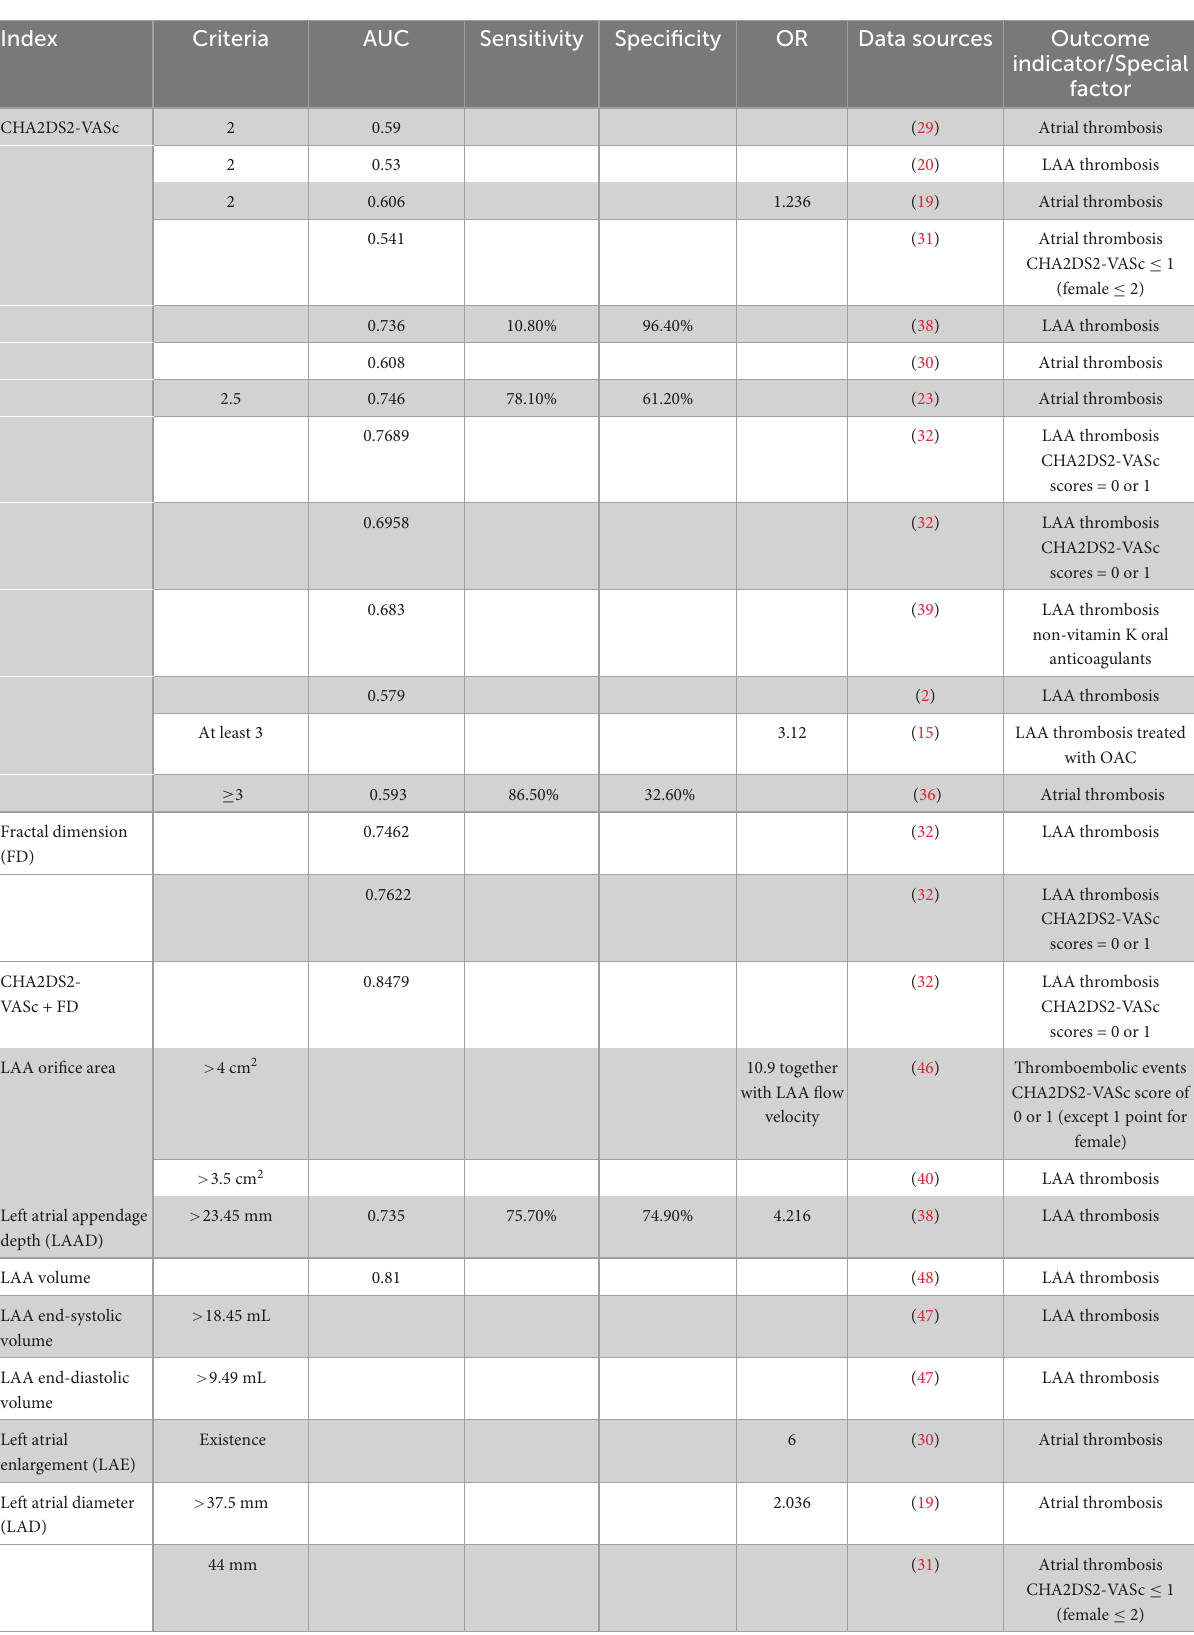
TABLE 1 Data and resources of the parameters